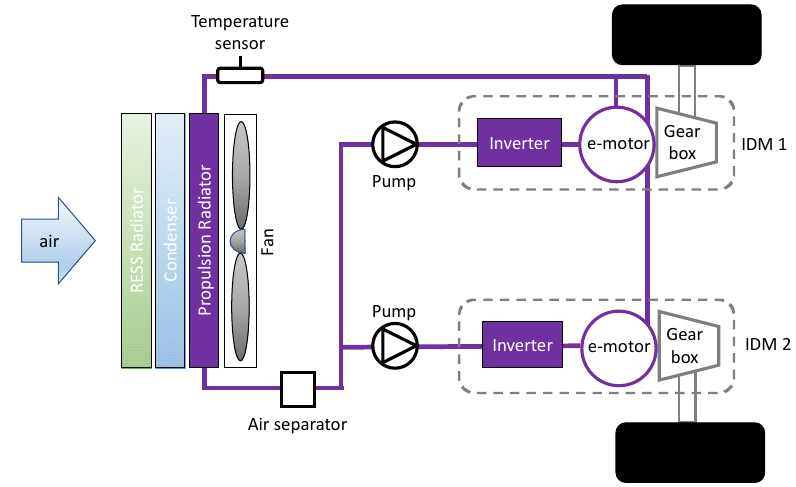
Figure 3. Dual IDM propulsion system and cooling system.